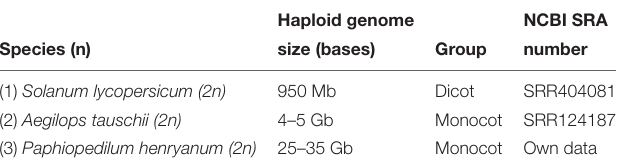
TABLE 1 | Species used in the study and their SRA